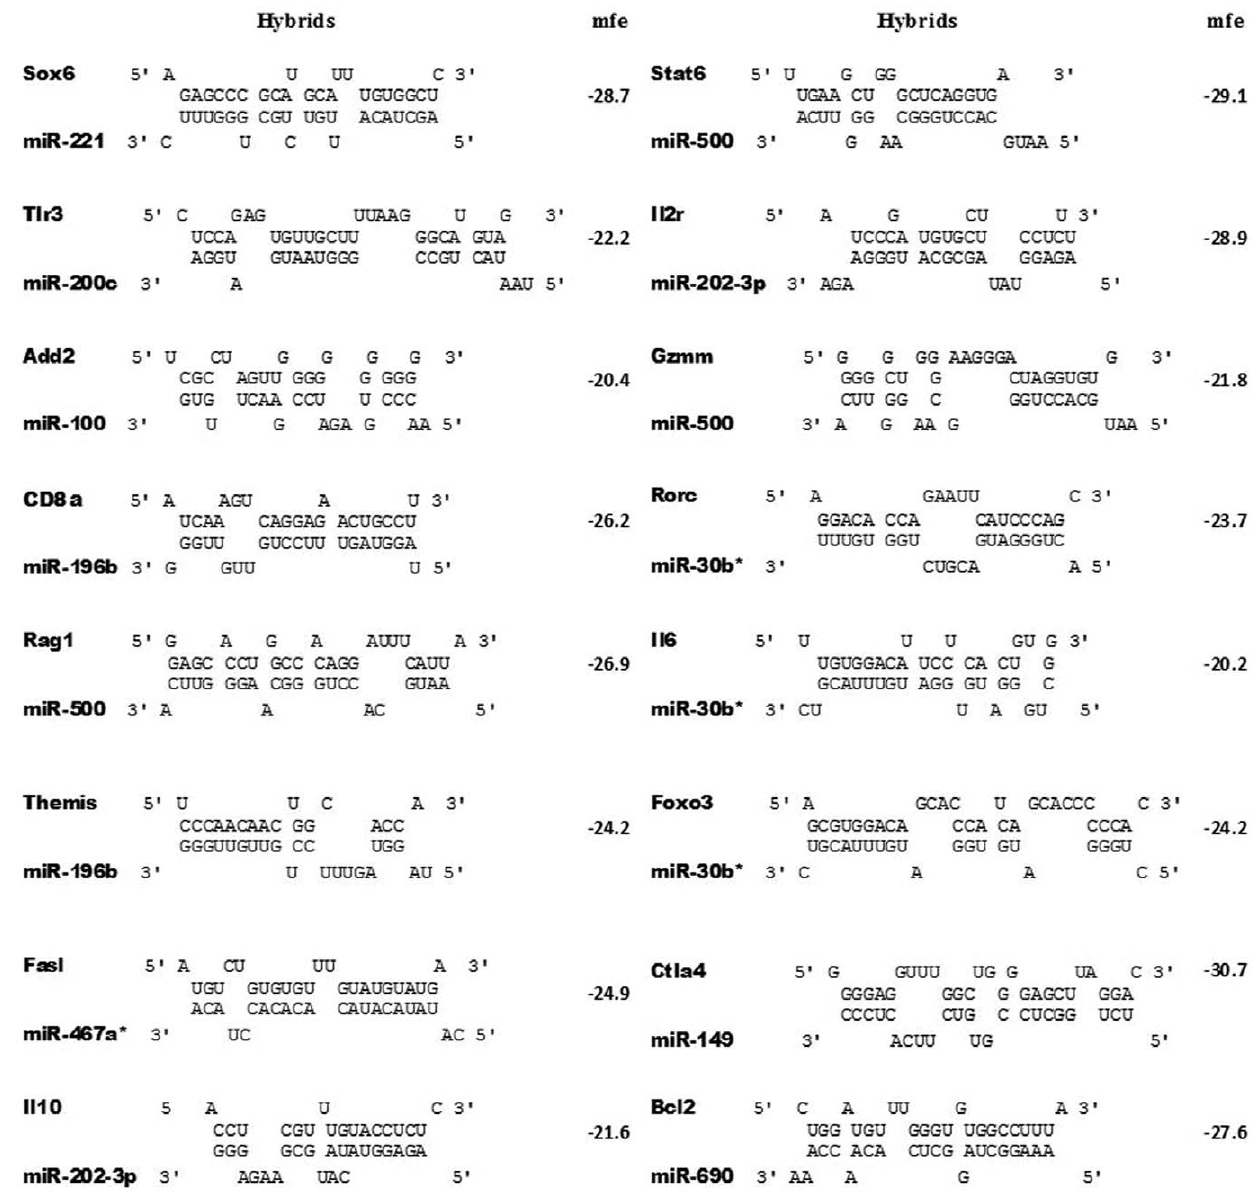
Figure 10. Validation of miRNA-mRNA interactions using RNAhybrid software. The miRNA:mRNA hybrid structures were calculated for selected examples of miRNA-mRNA interactions from GenMir ++ predictions. Sixteen miRNA:mRNA hybrid structures are presented. The miRNA binding site of the target mRNA is shown at the top, the complementary miRNA is shown at the bottom strand, and the calculated minimum free energy (MFE) values are given to the right (kcal/mol). The gene names as well as the designation of the miRNA (miRBase) are shown to the